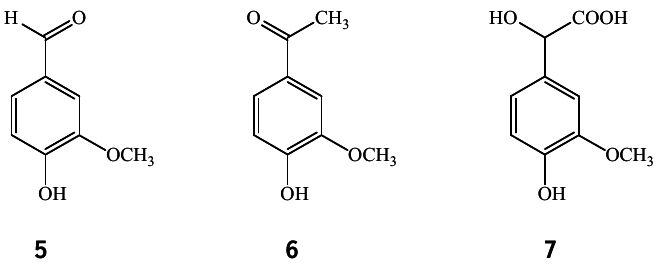
Figure 2. Main oxidation products of isoeugenol: vanillin ( 5 ), acetovanillone ( 6 ) and vanillylmandelic acid ( 7 ), as detected by GC-MS analysis.